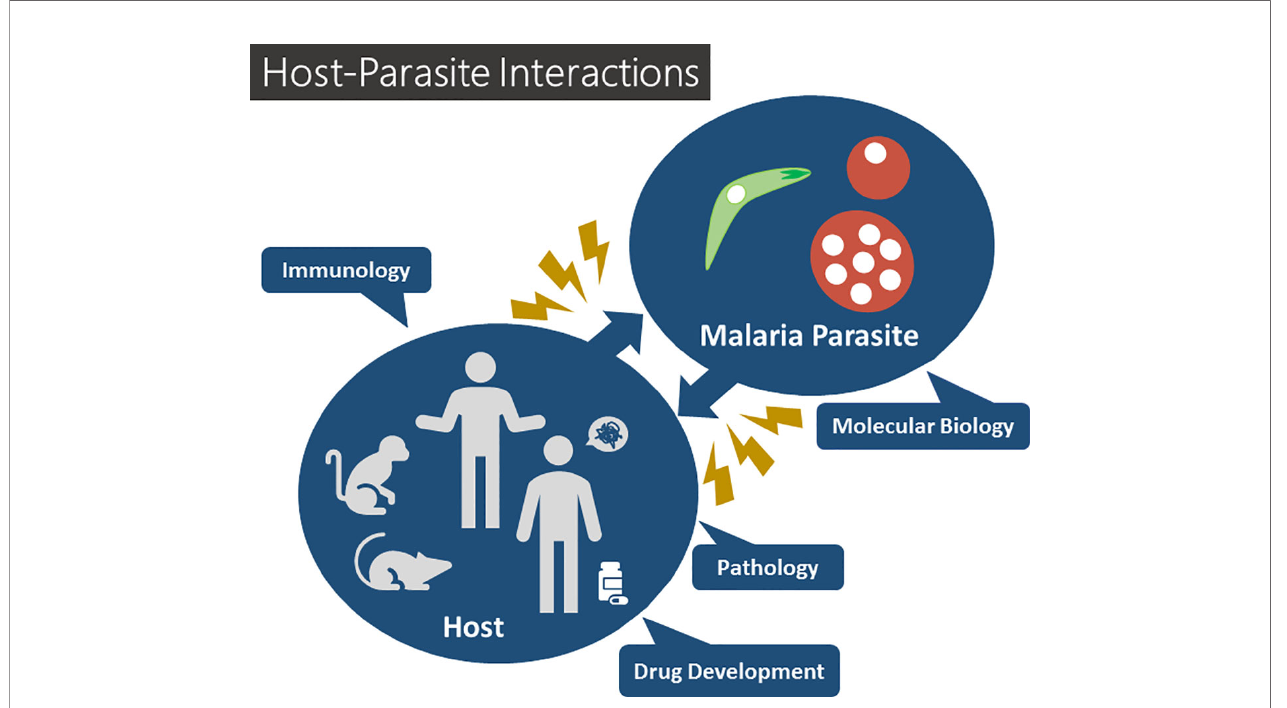
FIGURE 1 | Host-parasite interactions in